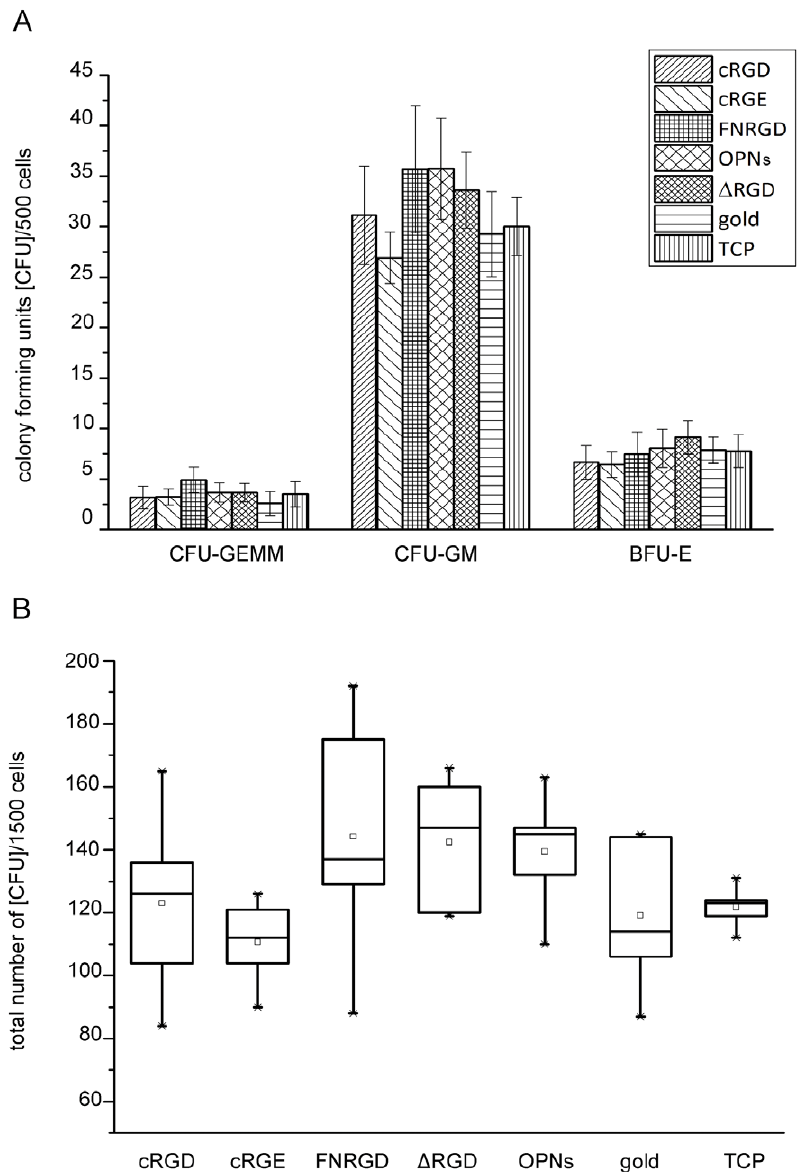
Figure 5. Determination of HSPC differentiation in colony forming assays. (A) Colony forming units of precultured HSPCs on glass slides biofunctionalized with different ligands. After 7–10 days preculture, colony forming assays were performed in triplicates. Colonies were distinguished into CFU-GEMM ( colony forming unit granulocyte, erythroid, macrophage, megakaryocyte ), CFU-GM ( colony forming unit granulocyte, macrophage ) and BFU-E ( burst forming unit erythroid ) after 2 weeks. N independent experiments= 5 in technical triplicates; error bars=standard error of the mean. (B) Box Plot of the total number of colony forming units formed by 1500 precultured HSPCs on glass slides biofunctionalized with different ligands. N independent experiments= 5; TCP=tissue culture plastic, gold=continuous gold film on glass, FN D RGD is abbreviated with ‘‘ D RGD’’.